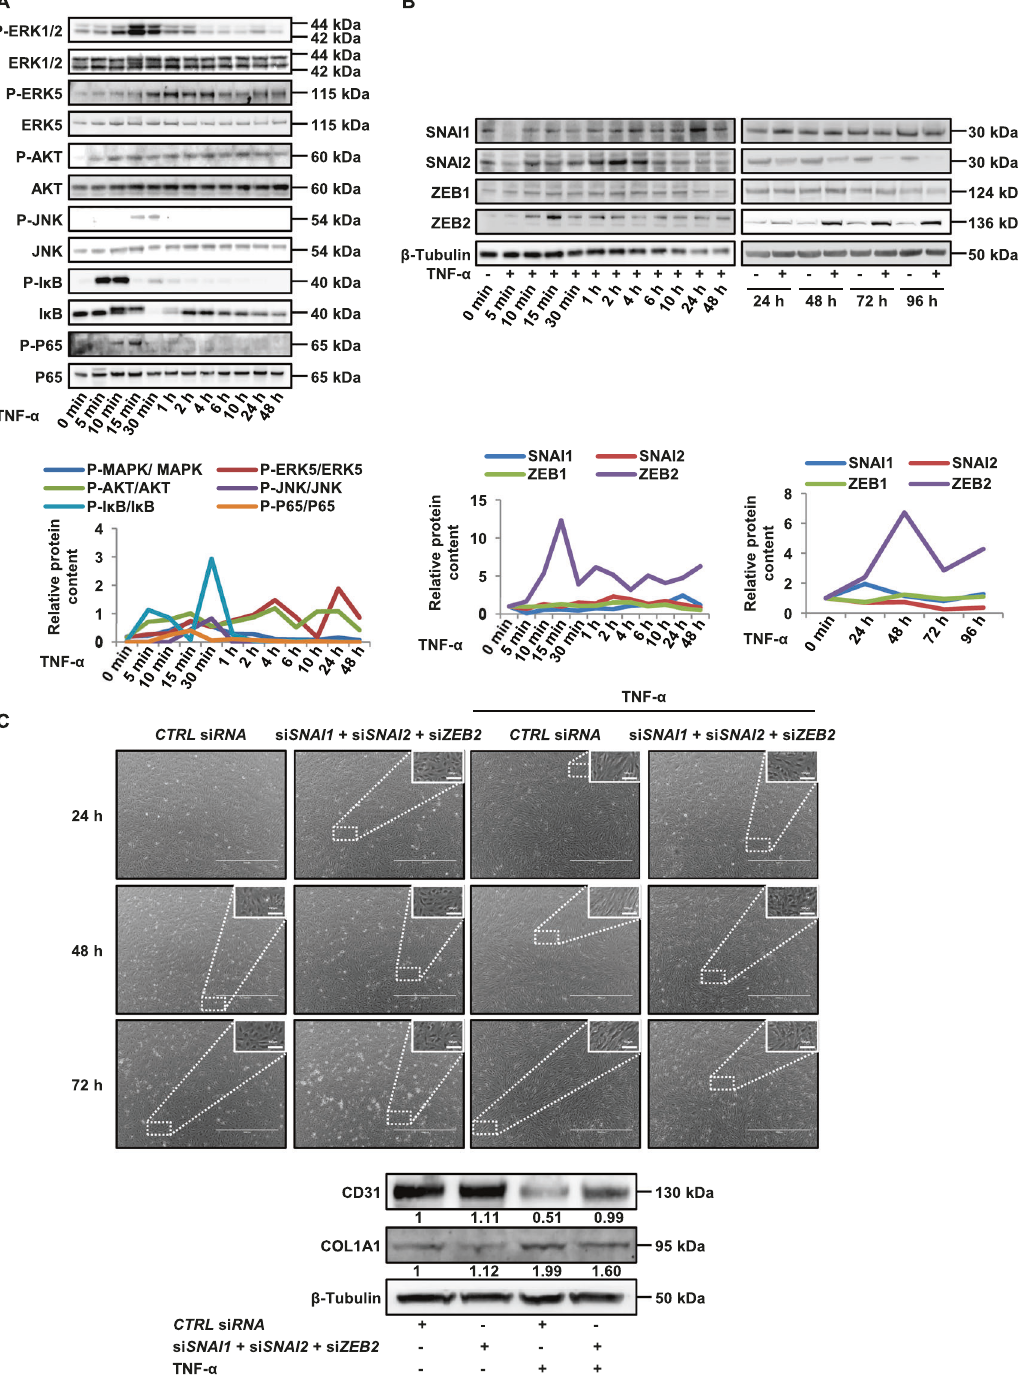
Fig. 3 Effects of TNF- α on signal transduction. A , B TNF- α increases Erk1/2, Erk5, Akt, JNK, IkB and P65 phosphorylations ( A ) and protein expression of SNAI1, SNAI2 and ZEB2 ( B ) analysed by western blot. HMVECs were treated for various times with 100 ng/ml of TNF- α . Western blot quanti fi cations are plotted on the graphs below. C SNAI1 , SNAI2 and ZEB2 de fi ciencies partially prevented the morphological changes induced by TNF- α (upper panel) and abrogated or partially reverted the modi fi cations induced by TNF- α on the expression of vascular endothelial marker (CD31) and mesenchymal markers (COL1A1) (lower panel). HMVECs were transfected with SNAI1 , SNAI2 and ZEB2 or CTRL siRNA and treated for various times with 100 ng/ml of TNF- α . Total ERK1/2, ERK5, Akt, JNK, IkB, P65 and β -tubulin were used as controls for western blots. Data are representative of three independent experiments. Scale bars, 100 µm (inset) or 1000 µm. HMVEC human microvascular endothelial cell, TNF- α tumour necrosis factor- α , Erk1/2, 5 extracellular signal-regulated kinase 1/2, 5, COL1A1 collagen type I α 1, Ctrl control, siRNA short-interfering